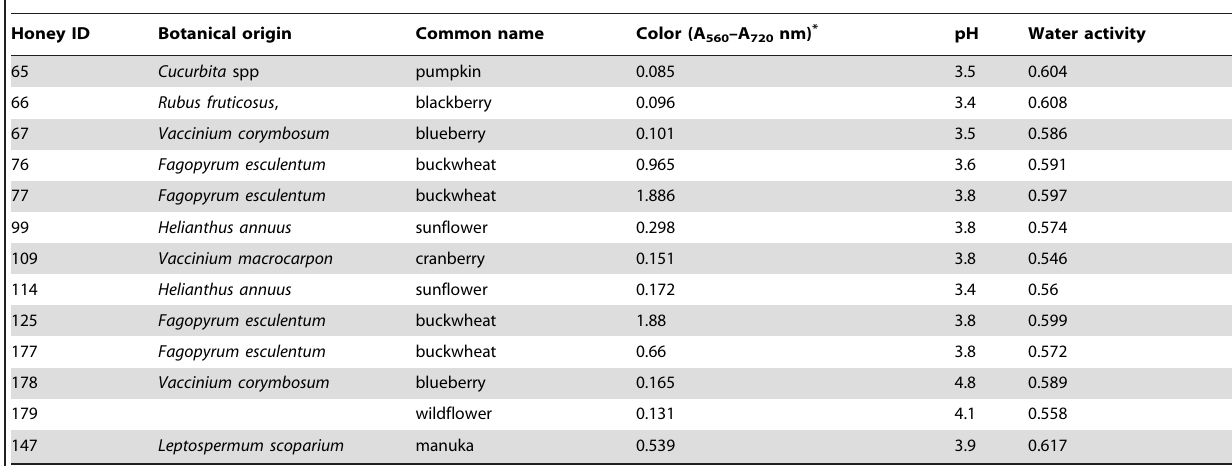
Table 1. List of